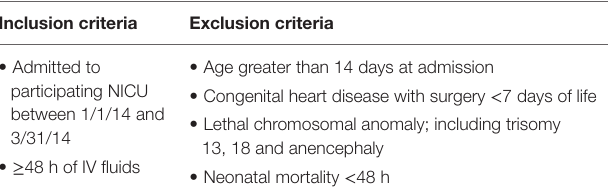
tablE 5 | inclusion and exclusion